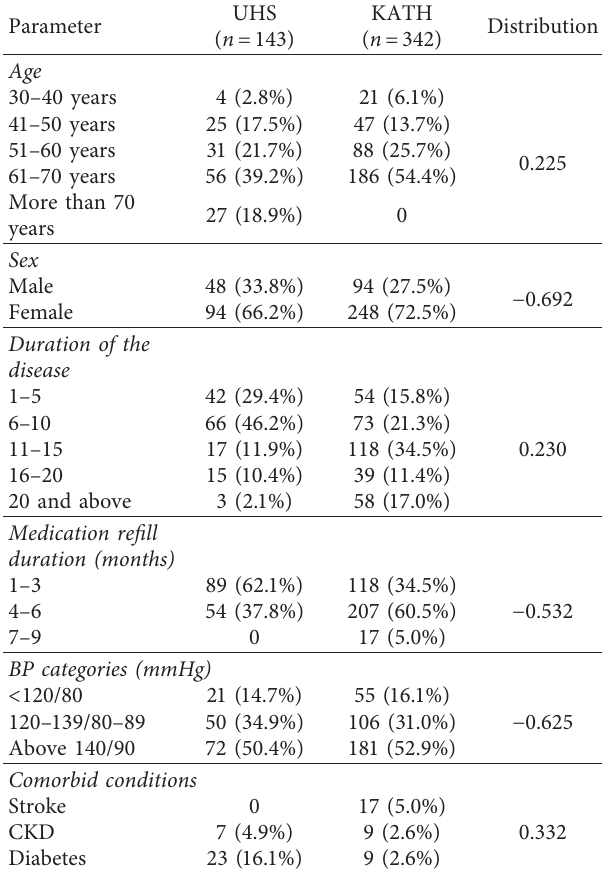
Table 1: Demographic characteristics of